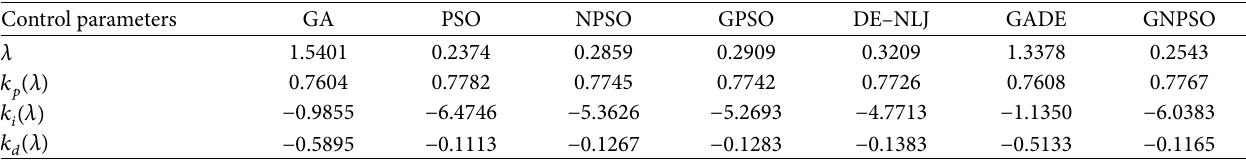
Table 10: Optimization results of IMC-PID controller parameters obtained by GA, PSO, NPSO, GPSO, DE–NLJ, GADE and GNPSO asso- for nonlinear wing vibration system. ciated with 𝐹 𝑚𝑎𝑥